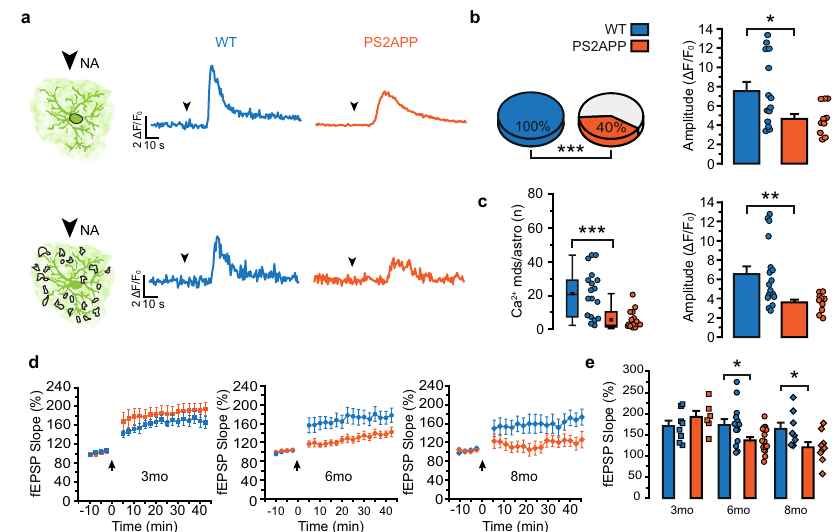
Fig. 3 | NA-evoked astrocyte Ca 2+ response and LTP in SSCx brain slices. a Representative traces of NA-evoked Ca 2+ activity in somata (top) and Ca 2+ mds (bottom) from 6mo WT (blue) and PS2APP (orange) mice. Arrowheads mark the start of NA perfusion. b Left, pie charts reporting the percentage of responsive somata, p =0.0001. Right, bar histograms (mean±SEM) and scatter plots report- ing amplitude response, p =0.043. 6mo: n =14 astrocytes from 2 WT and 25 astrocytes from 3 PS2APP mice. For amplitude only active somata have been considered. c Left, box and scatter plots reporting the number of Ca 2+ mds in individual astrocytes, p =0.00007. Box plots report mean, median, 25th and 75th percentile,outliers.Right,barhistograms(mean±SEM)andscatterplotsreporting